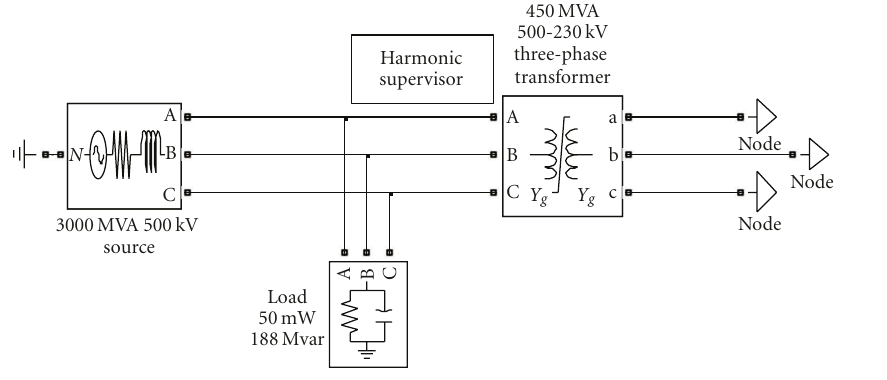
Figure 1: Configuration of test system 1.